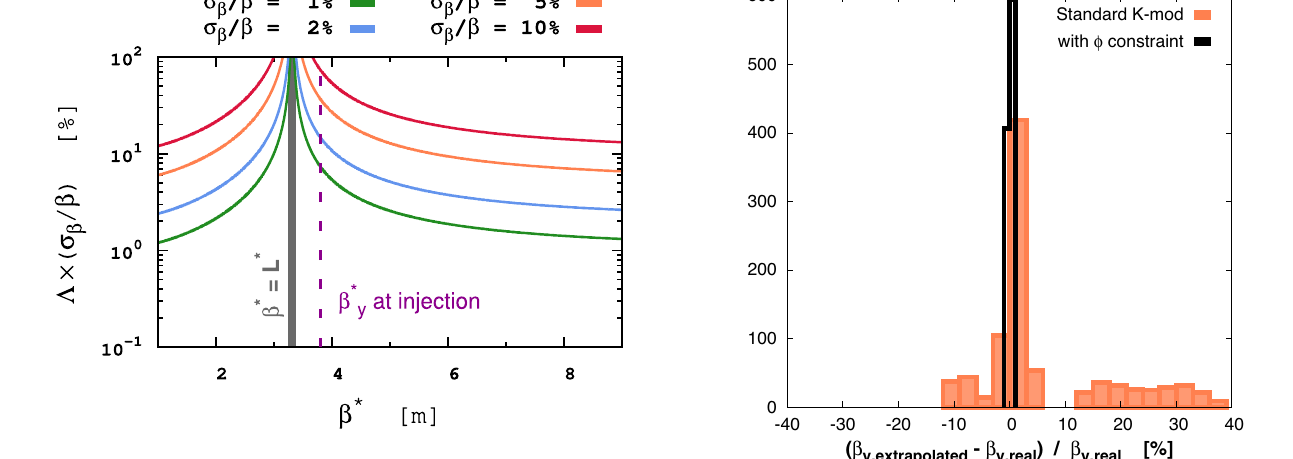
FIG. 13. Analytical uncertainty on extrapolated β , as deter- mined by Eq. (6), from the PS booster QFO in the wirescanner insertions.